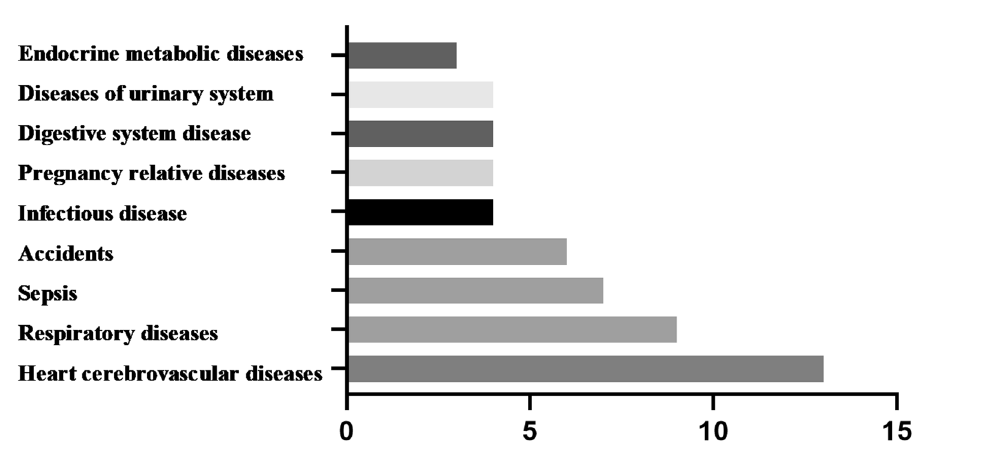
Figure 7. The main causes of non-tumor